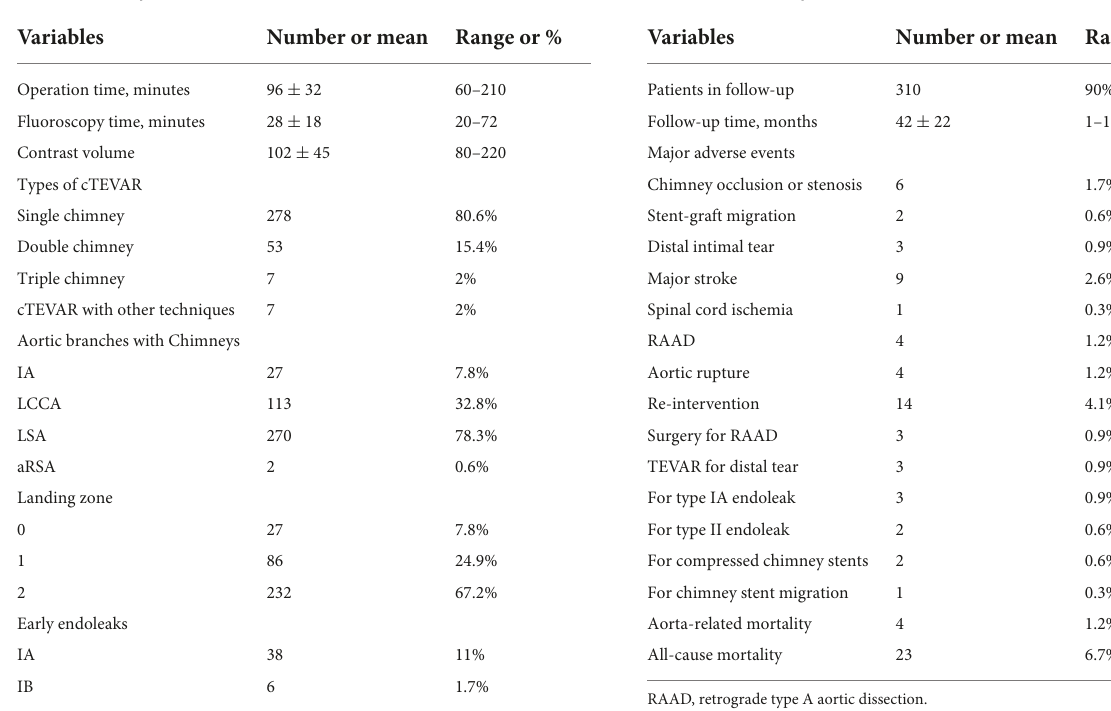
TABLE 2 Perioperative results. TABLE 3 Follow-up